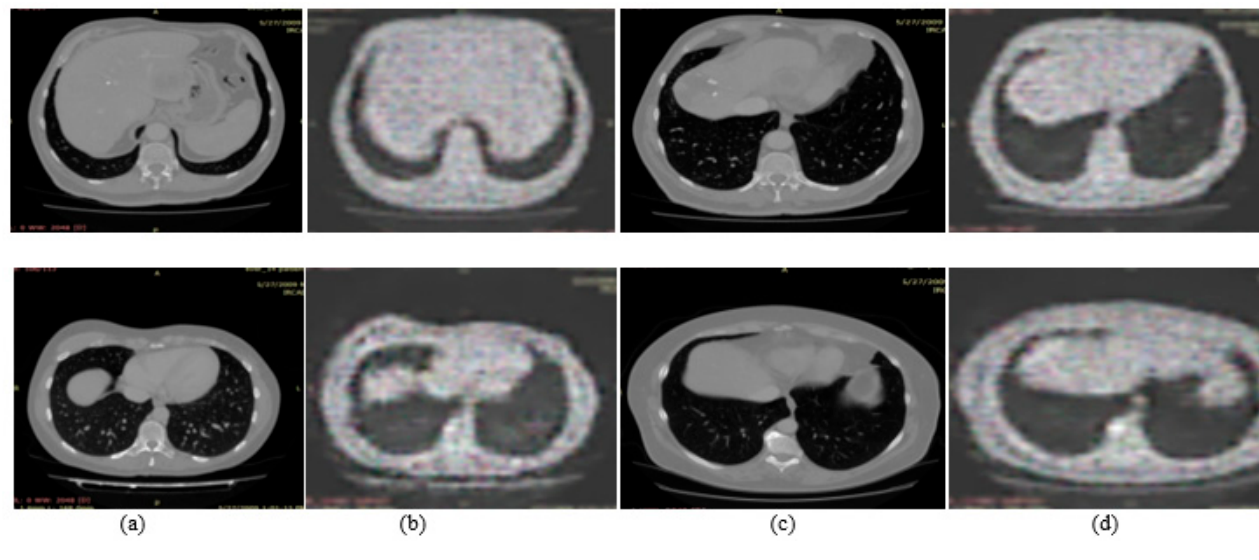
Figure 7. Synthetic images generation using GAN ( a , c ) input images ( b , d ) synthetic images.